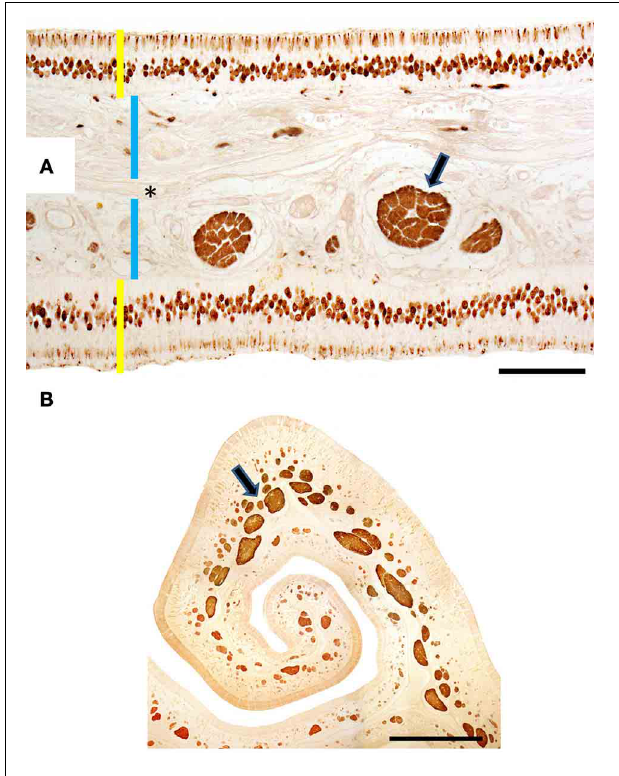
FIGURE 5 | Transverse sections of endoturbinate II stained with anti-OMP (A) and anti-G α o (B), showing labeling of mature neurons (in A) and nerve bundles (arrowed) of the olfactory mucosa. Yellow bars indicate sensory epithelium; blue bars, lamina propria; the asterisk, bone. Scale bars: (A) 100 μ m; (B) 1mm (see Figure S5).